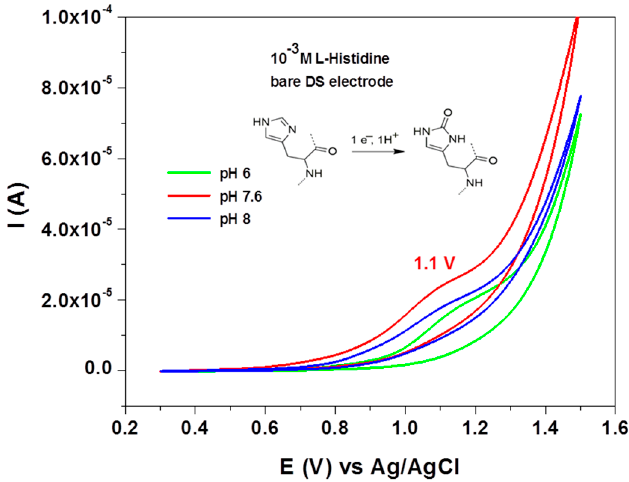
Figure3. CVsrecordedwithbareDSelectrodeinsolutioncontaining10 − 3 ML-Histidine; PBSsupporting Figure 3. CVs recorded with bare DS electrode in solution containing 10 − 3 M L-Histidine; PBS electrolyte: pH 6 (green); pH 7.6 (red); pH 8 (blue); scan rate 10 mV / s; inset: the electrochemical supporting electrolyte: pH 6 (green); pH 7.6 (red); pH 8 (blue); scan rate 10 mV/s; inset: the oxidation of electrochemical oxidation of L-Histidine.